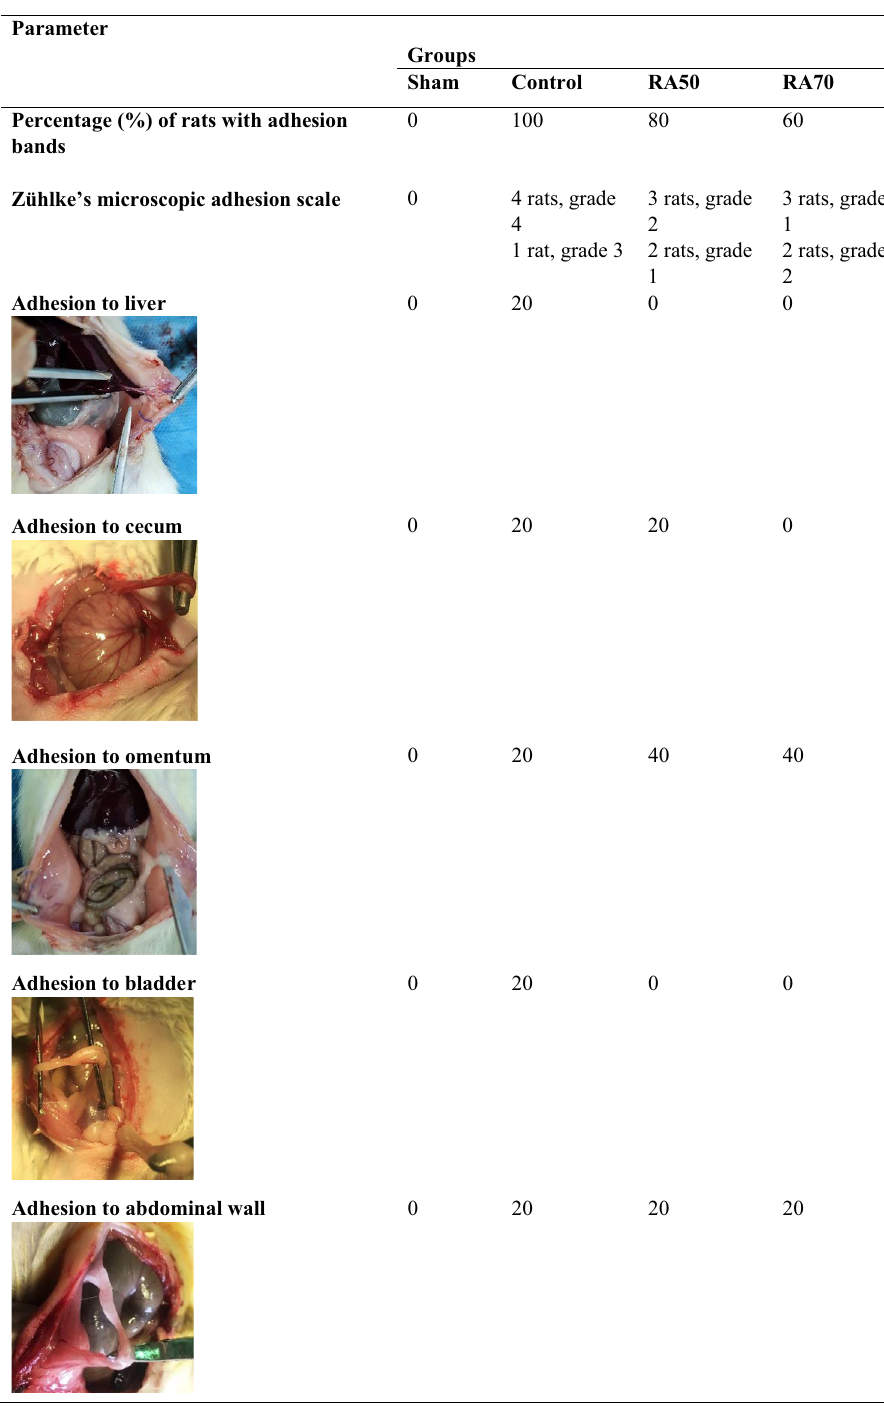
Table 1. Percentage of rats with adhesion bands, Zühlke’s microscopic adhesion scale, and visceral organs in which bands were attached. In the control group, rats developed more than one adhesion band in each group that was attached to various